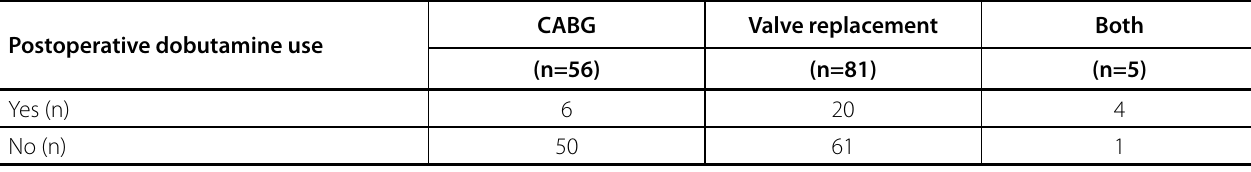
CABG=coronary artery bypass grafting P =0.0007 vs. valve replacement and the combination of both procedures.